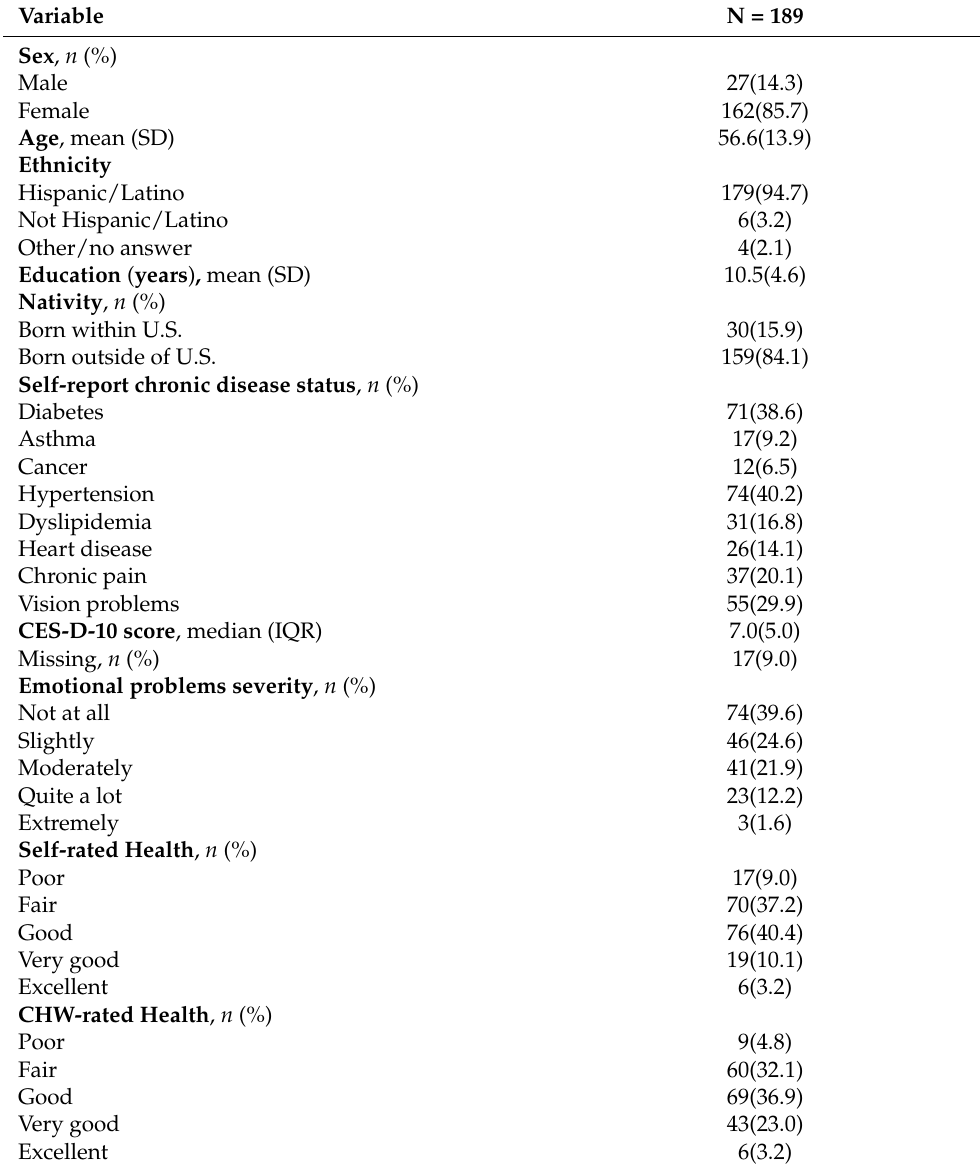
Abbreviations: CHW, Community health worker; LINKS, Linking Individual Needs to Community and Clinical Services; SD, standard deviation; CES-D-10, 10-item Center for Epidemiologic Studies Depression Scale